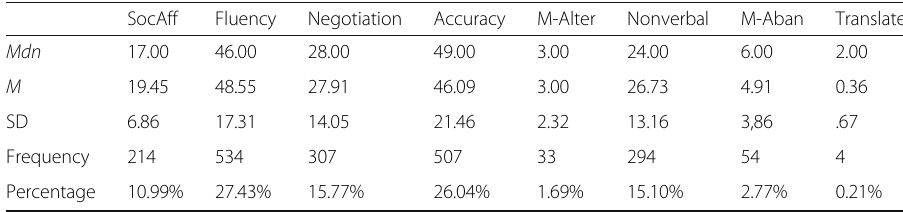
Table 2 Identified Communication Strategy